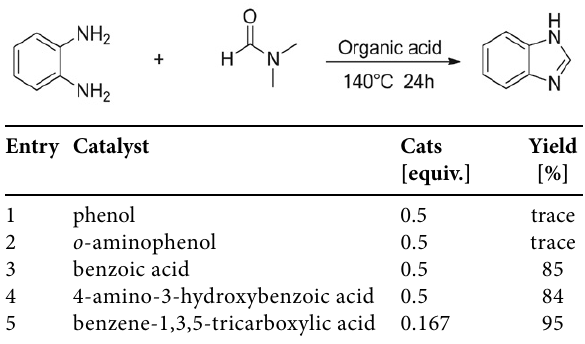
Table 2. The cyclization of o -phenylenediamine and DMF catalyzed by an organic acid